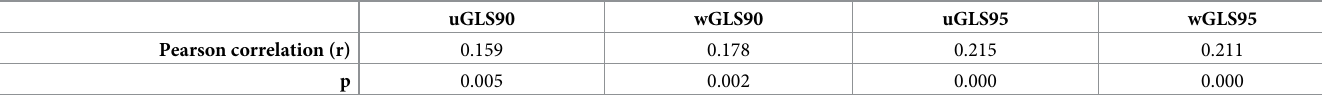
Table 5. Correlation between age at death and calculated genetic longevity scores.